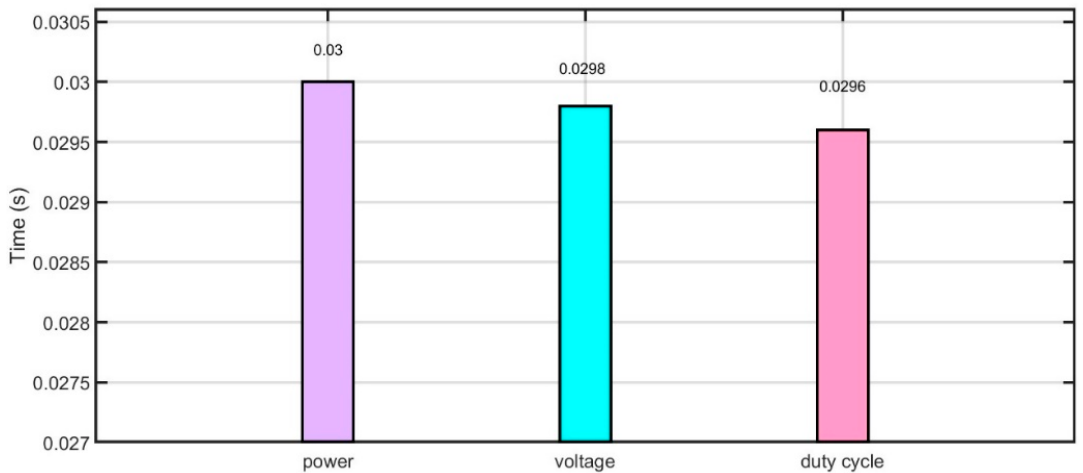
Figure 21. The steady-state restoration time using the IABC method.